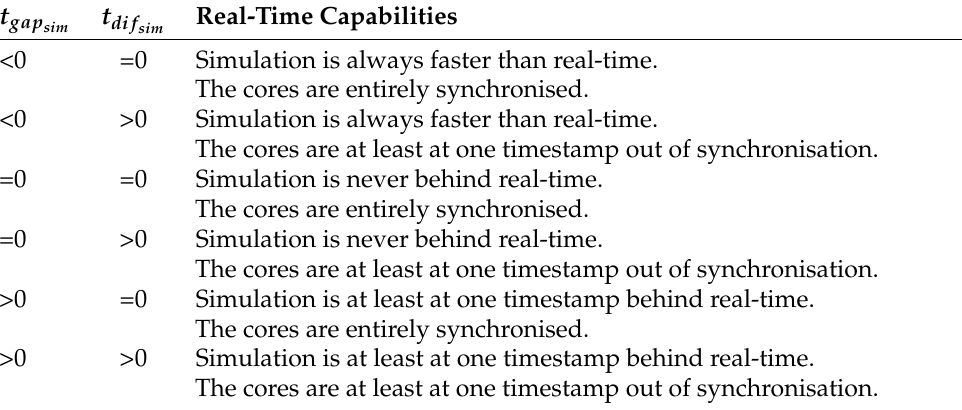
Table 1. Relationship between t gap lated system.